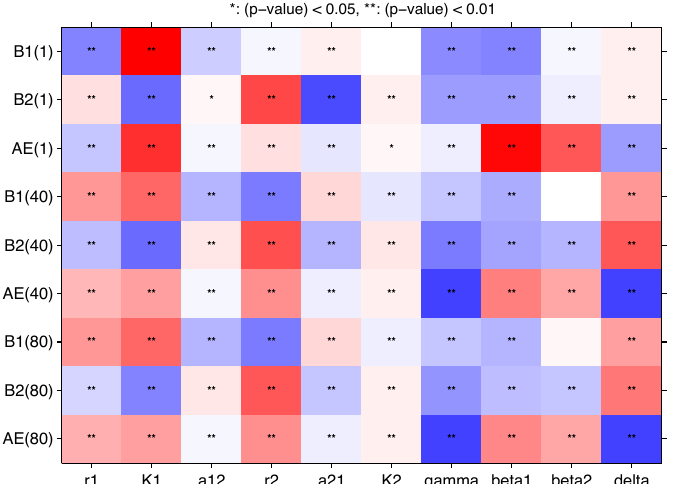
Figure B1. Sensitivity analysis of a mathematical model, Equations (3)–(5). General Latin hypercube sampling (LHS) scheme and partial rank correlation coefficient (PRCC) performed on the model. The reference outputs are the densities of bad bacteria ( B 1 ) and good bacteria ( B 2 ) and the concentration of inflammatory cytokines ( A E ) at time t = 1, 40, 80. The colors indicate PRCC values of all variables ( B 1 , B 2 , A E ) in the simple model (Equations (3)–(5)) for ten model parameters ( r 1 , K 1 , α 12 , r 2 , α 21 , K 2 , γ , β 1 , β 2 , δ ). Red color indicates positive correlations, and blue color